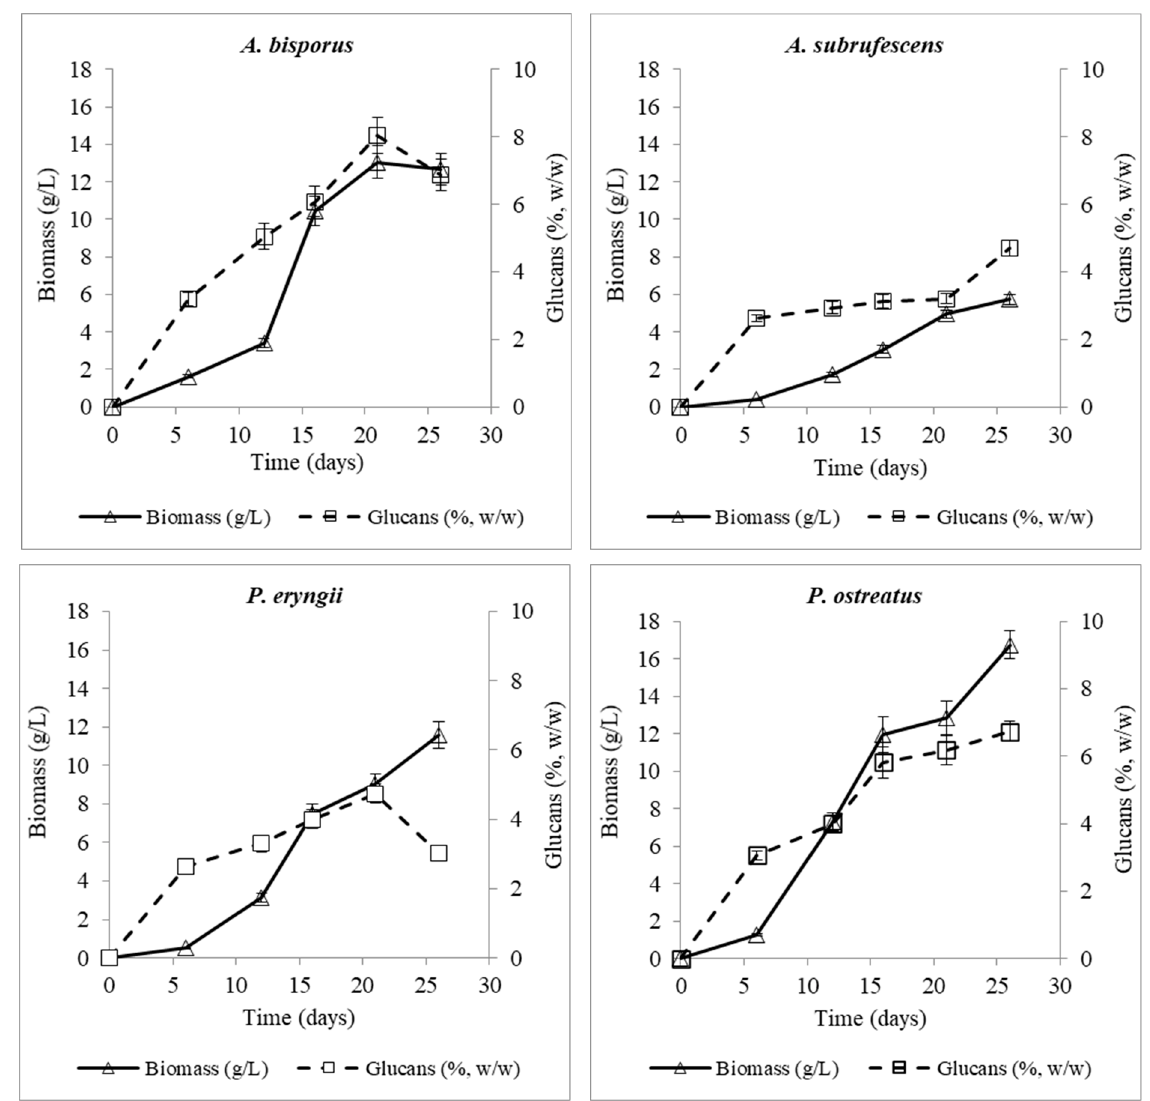
Figure 5. Total glucan-production patterns of A. bisporus , A. subrufescens , P. eryngii and P. ostreatus in relation to their produced biomass.